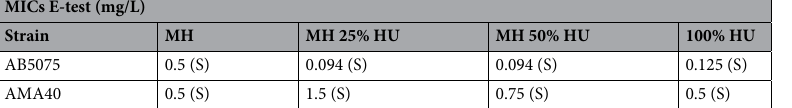
Table 1. Minimal Inhibitory Concentrations (MICs) of cefiderocol (CFDC) for AB5075 and AMA40 Carbapenem-resistant Acinetobacter baumanii representative strains performed using CFDC MTS strips (Liofilchem S.r.l., Italy) on Iron-depleted CAMHA (Cation Adjusted Mueller Hinton Agar). HU: Human Urine. A. baumannii cells were cultured in MH, MH supplemented with HU 25%, 50% or 100% HU.